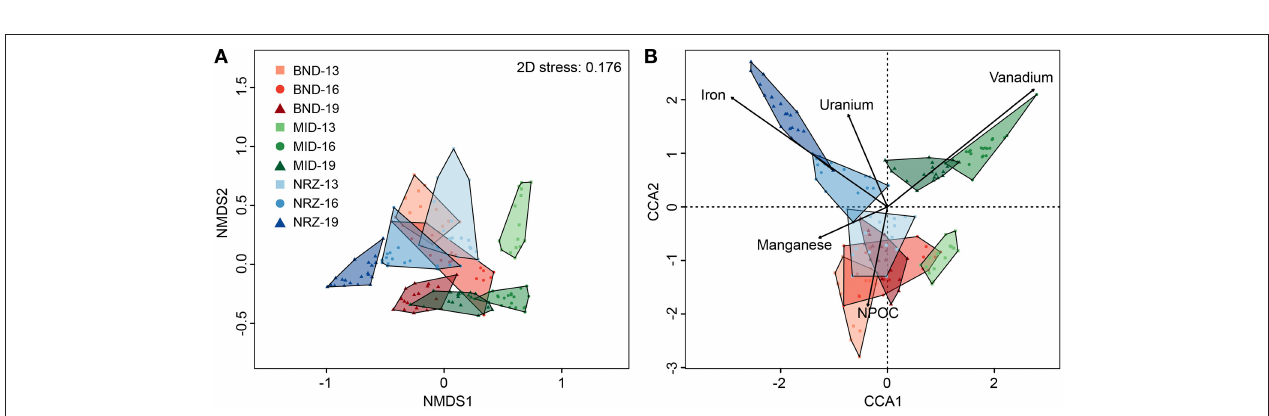
FIGURE 3 | Boxplots illustrating the test for homogeneity of geochemical parameters at the nine well-depth combinations. The lower the average “distance to centroid” the more stable the system is whereas a higher number denotes greater variation from the average, and therefore a less geochemically stable environment. Significant differences between locations are indicated by the colored circles located above the whiskers, with colors corresponding to other boxes. For example, BND-13 is significantly less stable than BND-16.